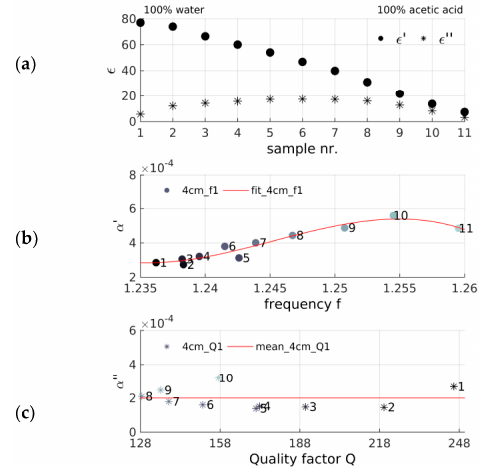
Figure 2. ( a ) Filling factor α calibration using mixtures spanning the range from 100% water (sample 1) to 100% acetic acid (sample 11): Permittivity real and imaginary part ε′ / ε″ computed for slim glass tubes filled with water-acetic acid sample inserted into cavity at full lenght; ( b ) resonant frequency f and ( c ) Quality factor Q plotted against α ’/ α ” values derived for each water-acetic acid mixture and the 4 cm tube depths including the 3rd order polynomial fit/mean value,